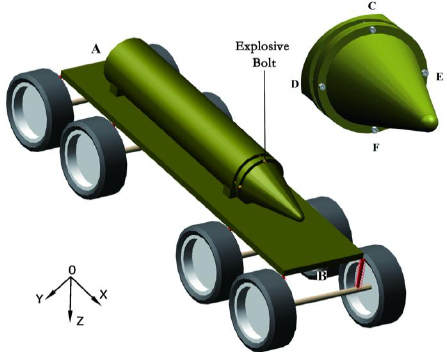
Figure 3. ADAMS prototype of missile vehicle.